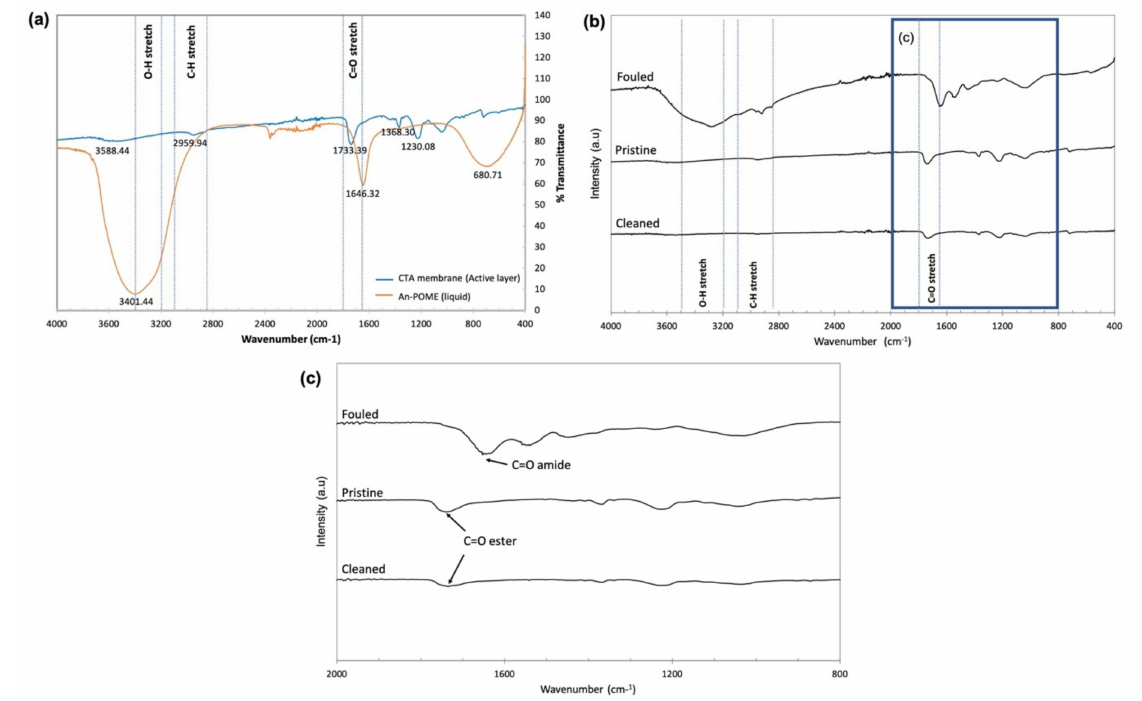
Figure 15. Fourier transform infrared spectroscopy (FTIR): ( a ) spectra of a pristine CTA membrane (active layer) and liquid An-POME; ( b ) stacked spectra of pristine, fouled, and cleaned CTA membranes on the active layer; ( c ) zoomed in at wavenumber 800–2000 cm − 1 for stacked spectra of pristine, fouled, and cleaned CTA membranes on the active